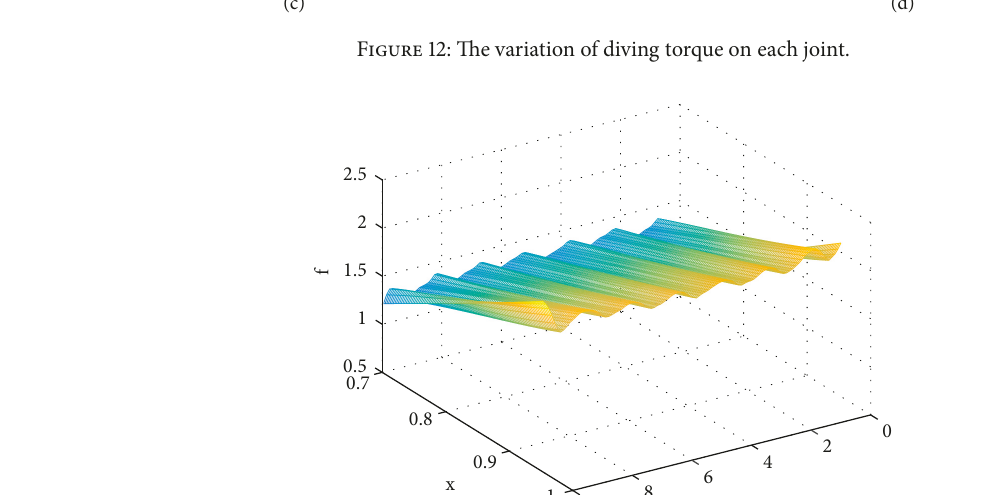
Figure 12: The variation of diving torque on each joint.